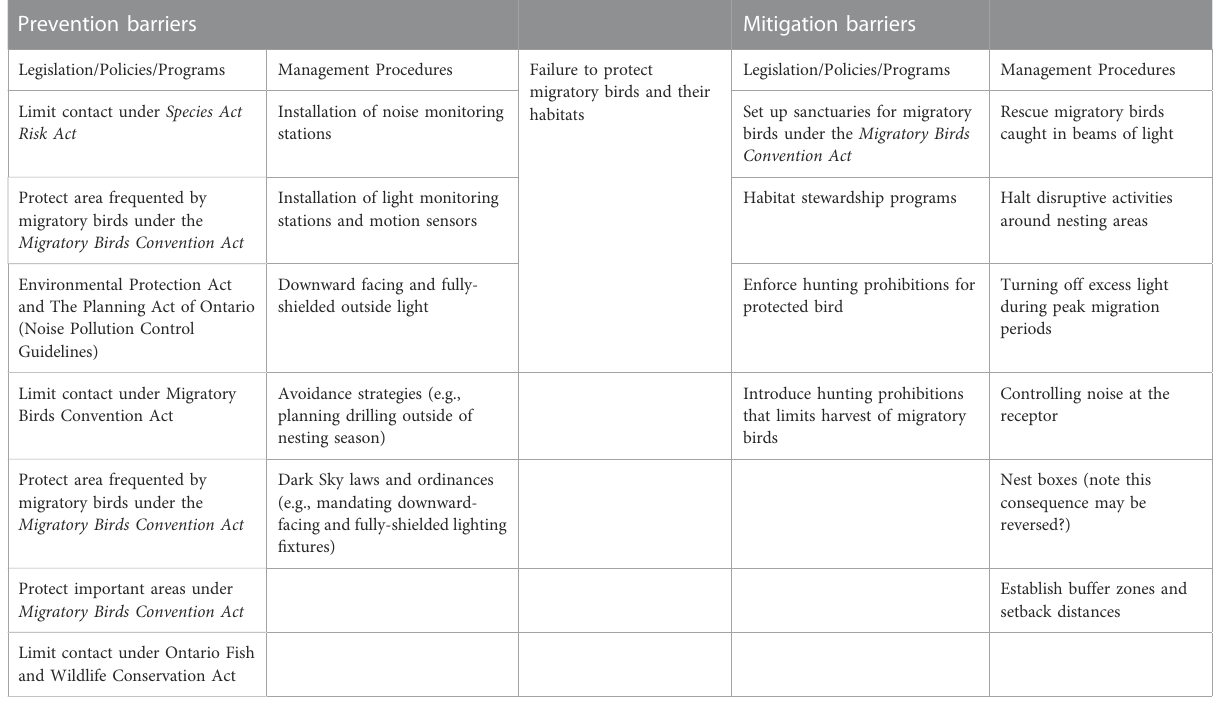
TABLE 8 Examples of management systems and policies to prevent and mitigate